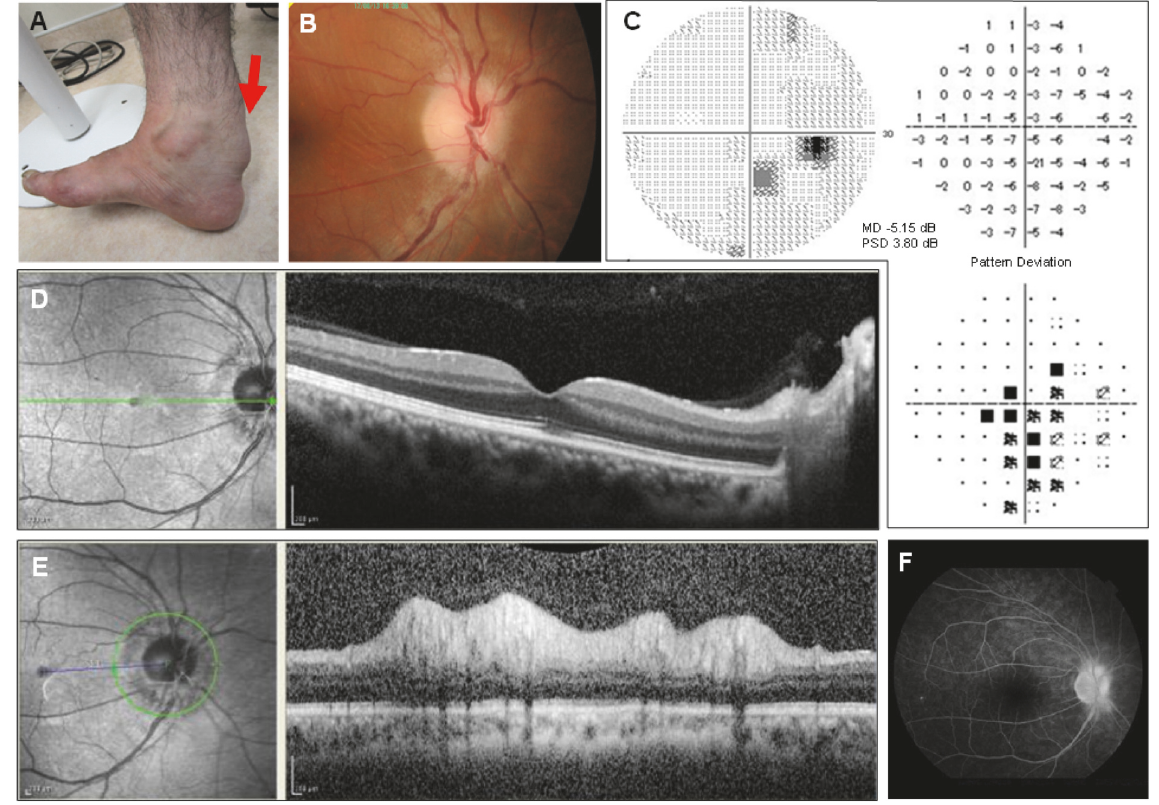
Figure 1: The patient’s enlarged right Achilles tendon (arrow), which indicated xanthoma (A). Funduscopic examination showed mild swelling in the nasal side of the right optic disc (B). Humphrey 30-2 visual field examination revealed a cecocentral scotoma in the right eye (C). OCT of the right eye demonstrated intact thickness of the retinal nerve fiber layer (RNFL) in the macula (D) and increased thickness of the peripapillary RNFL (E). Fluorescein angiography exhibited profuse dye leakage on the right optic disc